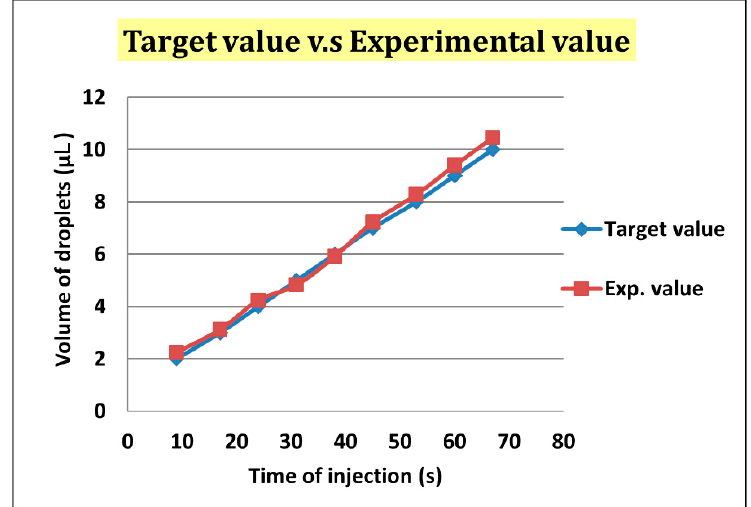
Figure 8. The error of the target volume and the experimental volume was less than 10%.